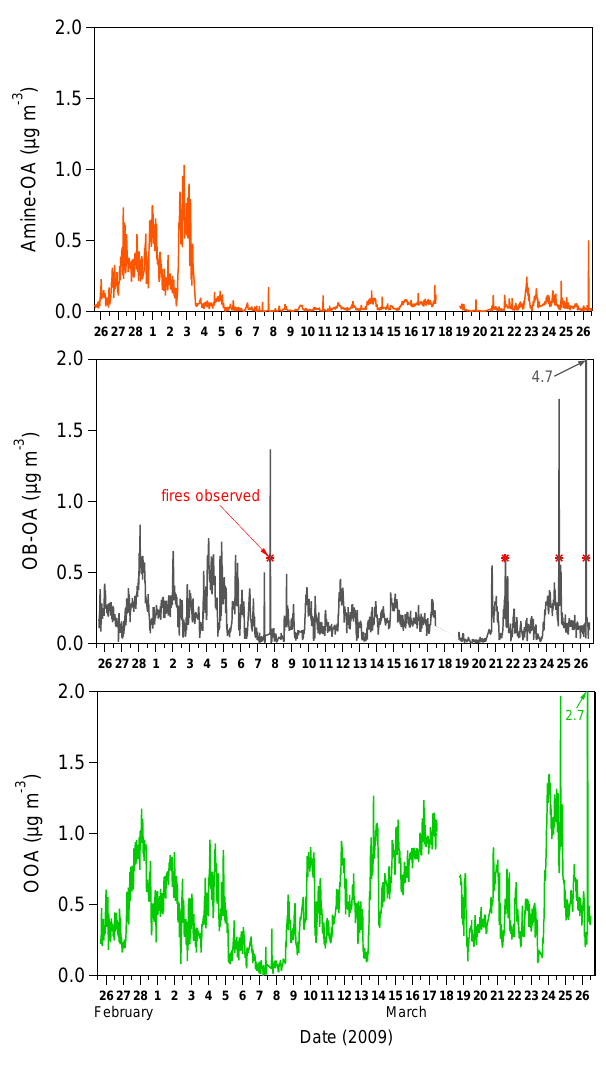
Fig. 7. Time series of OA components from the 3-factor PMF solu- tion. OOA was the most abundant OA component. OB-OA spiked when fires were observed from the field site. Amine-OA was more abundant during the first few days of the campaign when meteoro- logical conditions were milder.